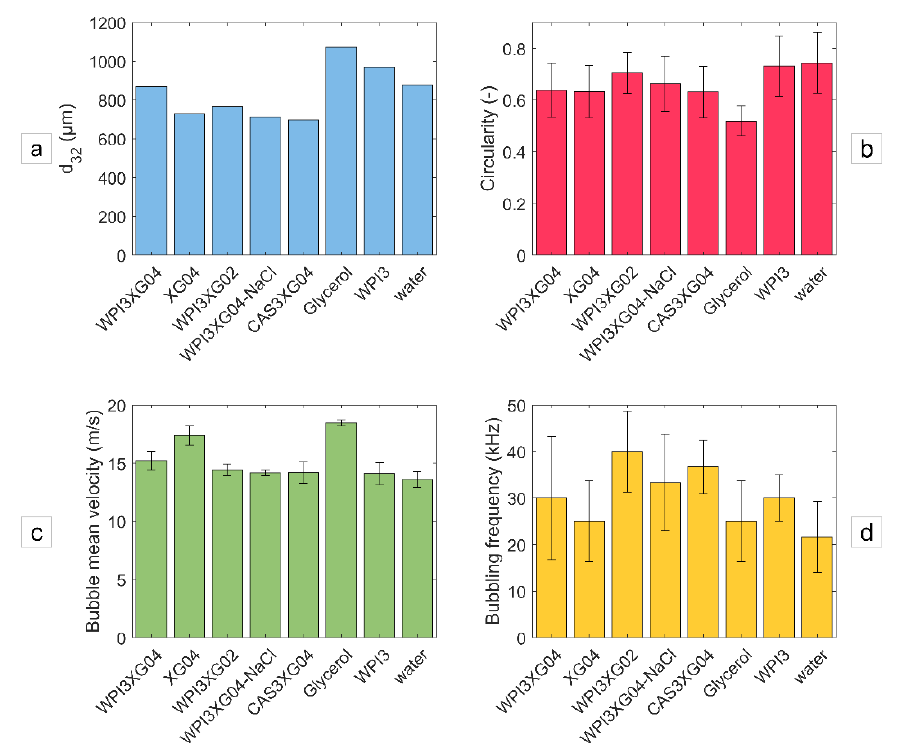
Figure 15. High-speed visualizations of the train of bubbles in the mixing channel of the device CX600 for several formulations at Q vL = 11 L.h −1 -Q mG = 21.6 g.h −1 . The liquid flowrate for